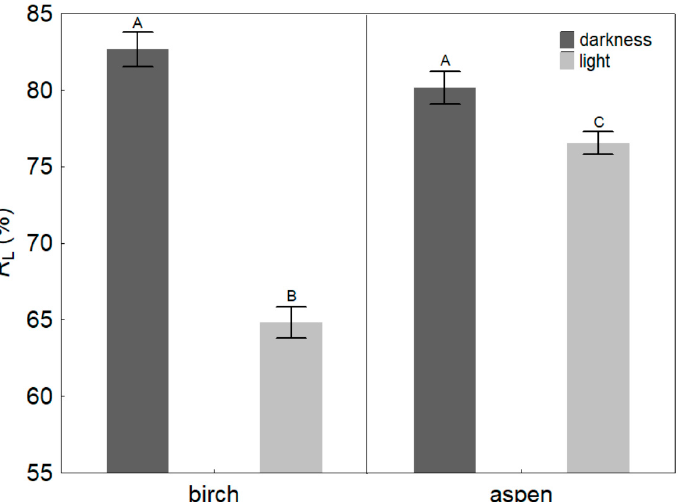
Figure 6. Relative hydraulic resistance (mean ±SE) residing in leaves ( R L ) of silver birch ( Betula pendula ) and hybrid aspen ( Populus × wettsteinii ) under dark or light conditions (exposure to PPFD 900–1000 μ mol m − 2 s − 1 for at least 1 h). Different letters express statistically significant ( p < 0.01) differences between the means.